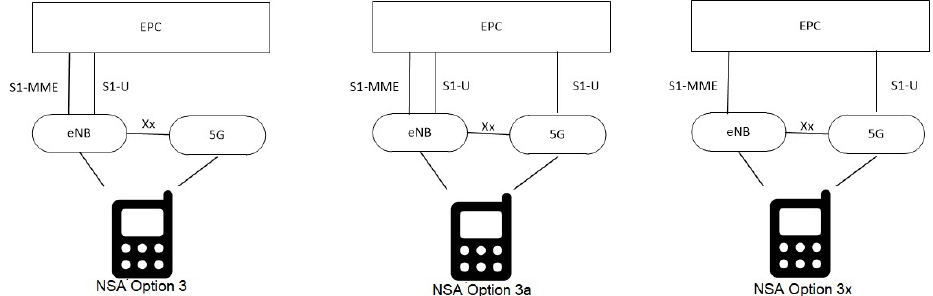
Figure 5. NSA Option 3 Variants: The initial deployments of 5G services are based on 5G NSA, also called Option